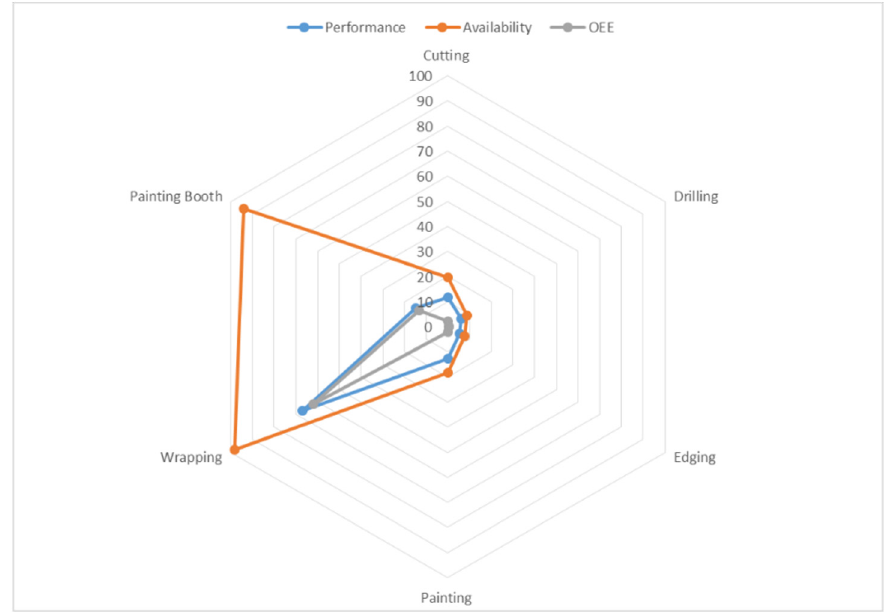
Figure 4. OEE radar chart.